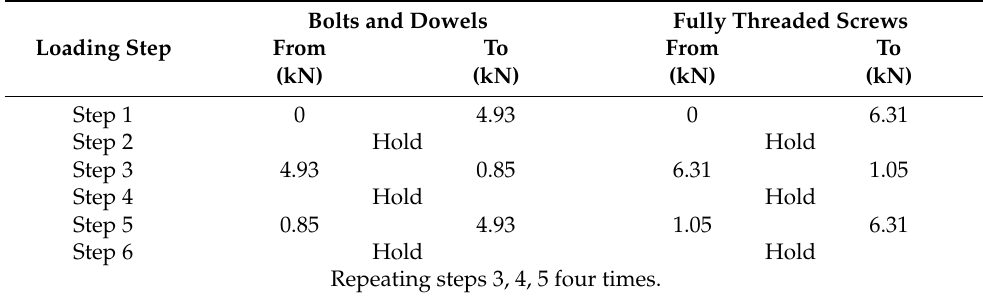
Table 1. The course of the 60% ULS experiment